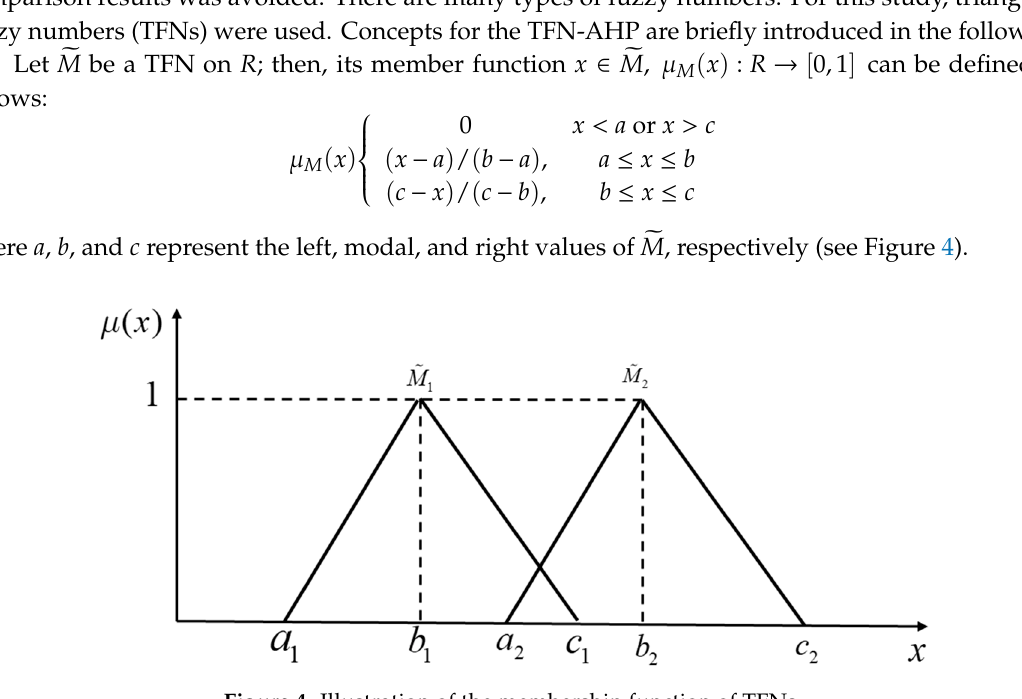
Figure 4. Illustration of the membership function of TFNs.